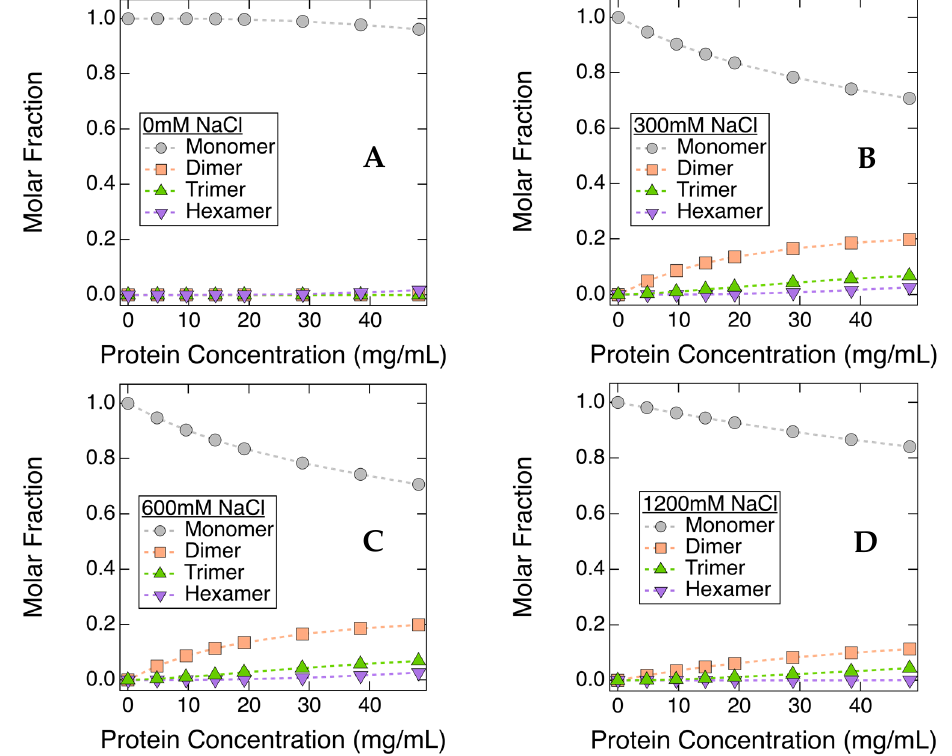
Figure 6. Molar fractions of ASA-IgG2 monomer and other self-association products in various NaCl solutions: 0mM NaCl ( A ), 300 mM NaCl ( B ), 600 mM NaCl ( C ), and 1200 mM NaCl ( D ). Although smaller than the plotting symbols, error bars represent standard errors.